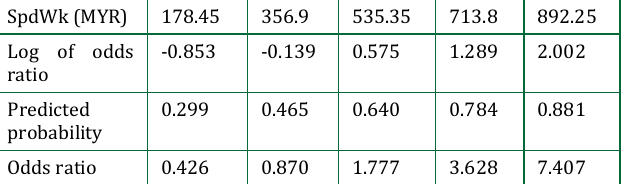
Table 5: Predicted probability and odds ratios with payment card